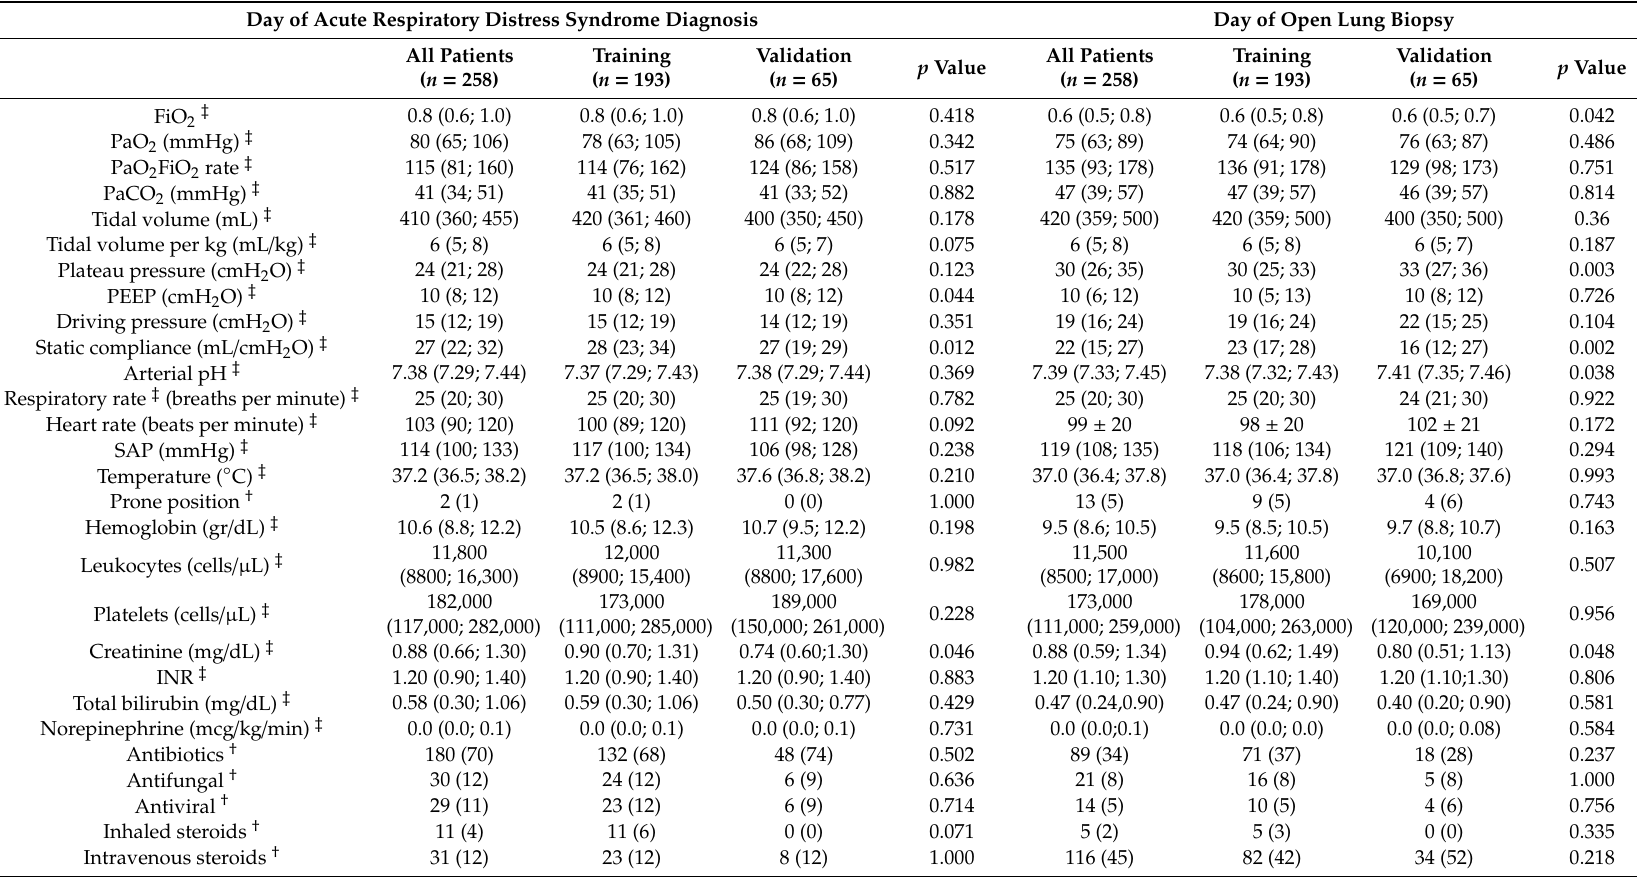
Table 2. Data at the time of ARDS diagnosis and of OLB in 258 ARDS patients in the training and validation cohorts. Day of Acute Respiratory Distress Syndrome Diagnosis Day of Open Lung Biopsy All Patients ( n =